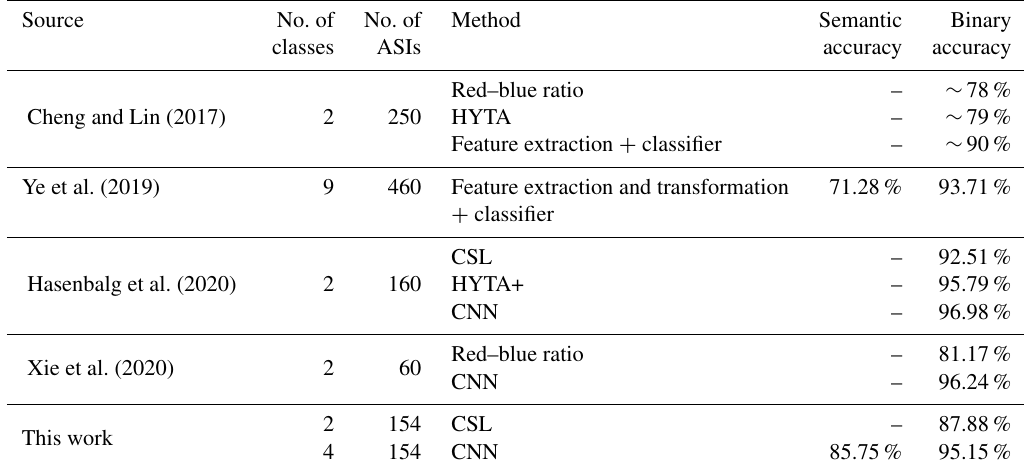
Table 4. Comparison of our results with the literature. Number of ASIs refers to the number of images used for validation.